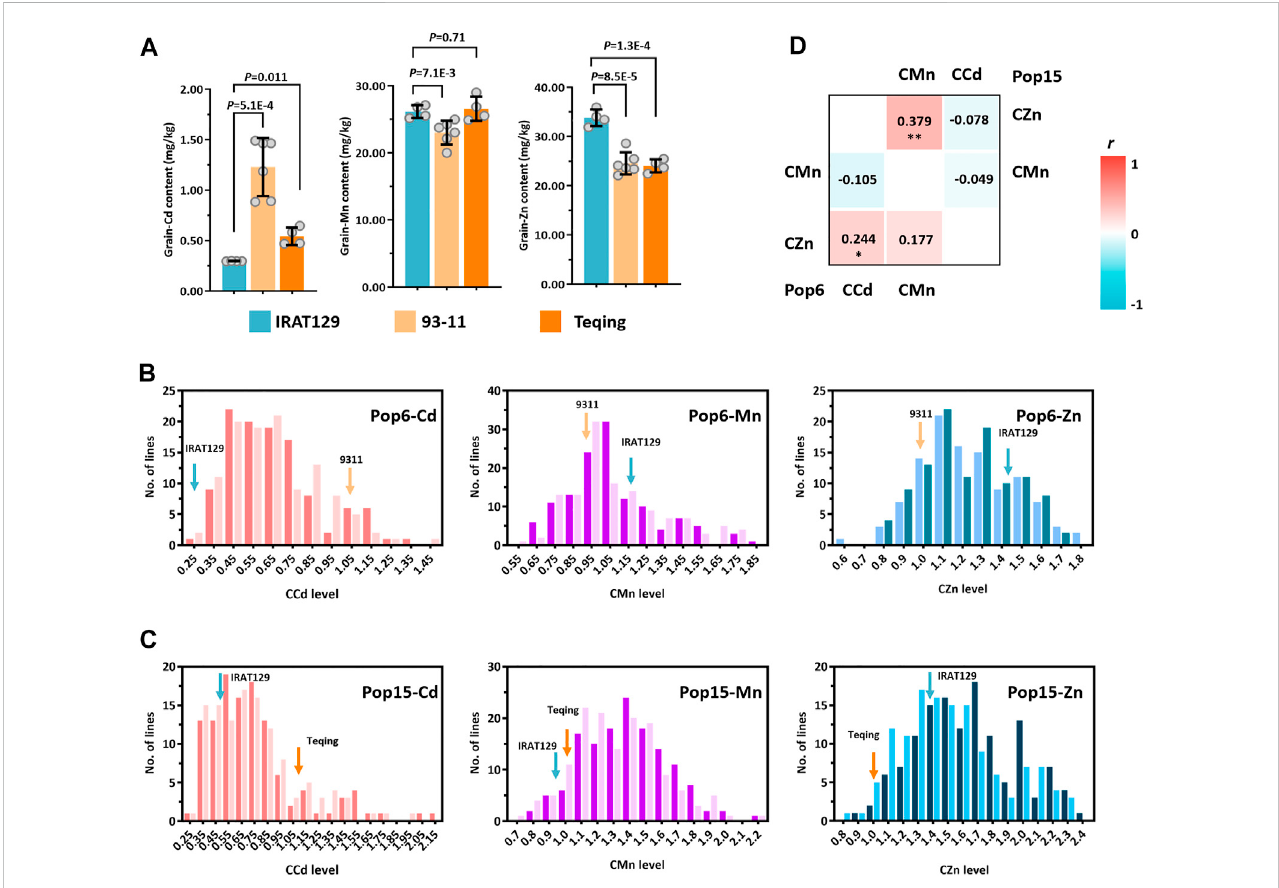
FIGURE 2 DistributionofCCd,CMn,andCZnintwoRILpopulationsderivedfrom “ IRAT129 ” , “ 93 – 11 ” ,and “ Teqing ” varieties. (A) Comparisonoftheaccumulationof grain-Cd, grain-Mn, and grain-Zn inthe grains of the three parental varieties ofrice. (B) and (C) Distribution of CCd, CMn, and CZn in the twoRIL populations. Thearrowsrepresenttheperformanceoftheparentallines. (D) Theresultsofcorrelationanalysisofthemineralaccumulation inthetwoRILs.Thecorrelation coef fi cients (r) are labeled, and * p < 0.05 and ** p < 0.01 represent signi fi cant